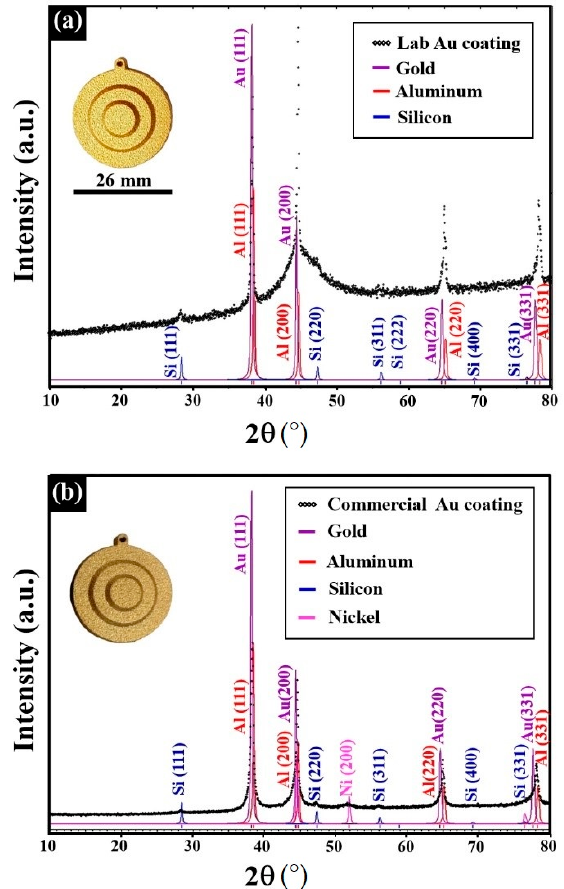
Figure 9. XRD patterns of the AlSi10Mg printed disk-shaped specimens electroless gold plated, the dark line represents the current experimental results: ( a ) laboratory-developed Au coating and ( b ) commercial Au-plated coating.